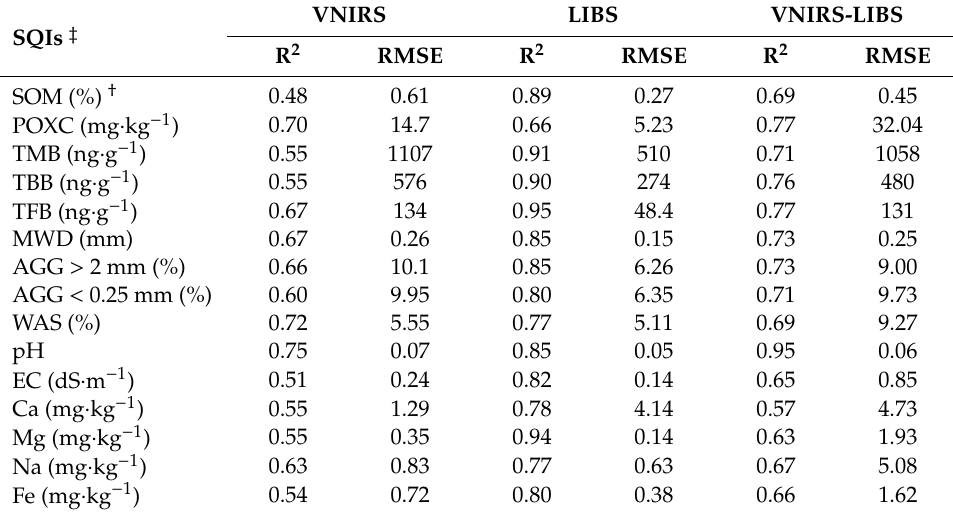
Table 6. Calibration R 2 and RMSE values for visible-near infrared spectroscopy (VNIRS), laser-induced breakdown spectroscopy (LIBS), and combined VNIRS-LIBS using data from NMSU Agricultural Science Center in Los Lunas, NM (n =